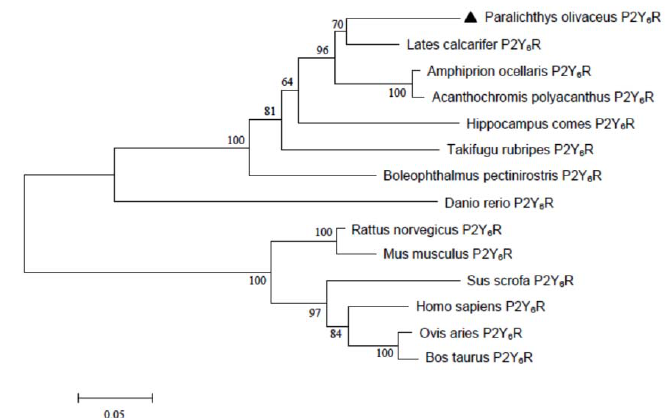
Figure 2. Phylogenetic relationship analysis of Japanese flounder P2Y 6 receptor and its counterparts from selected mammalian and fish species. Protein sequences were aligned with the ClustalW program and the maximum-likelihood phylogenetic tree was constructed using MEGA software version